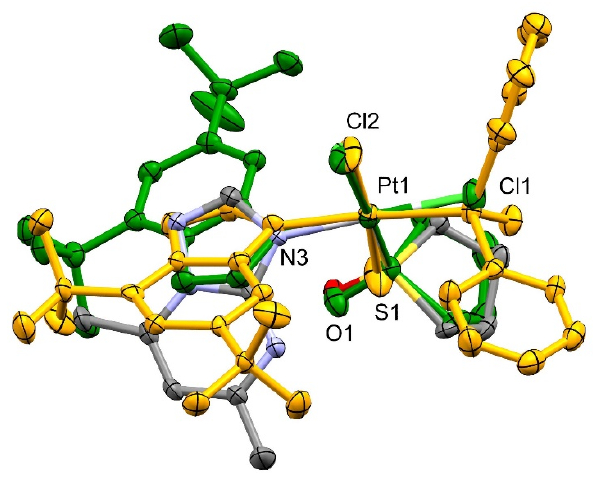
Figure 3. Structures superposition of ( A1 ) (atoms: C gray , N blue , O red ), ( A3 ) ( green ) and ( B3 ) ( yellow ). Heteroatoms are labeled for ( A1 ).